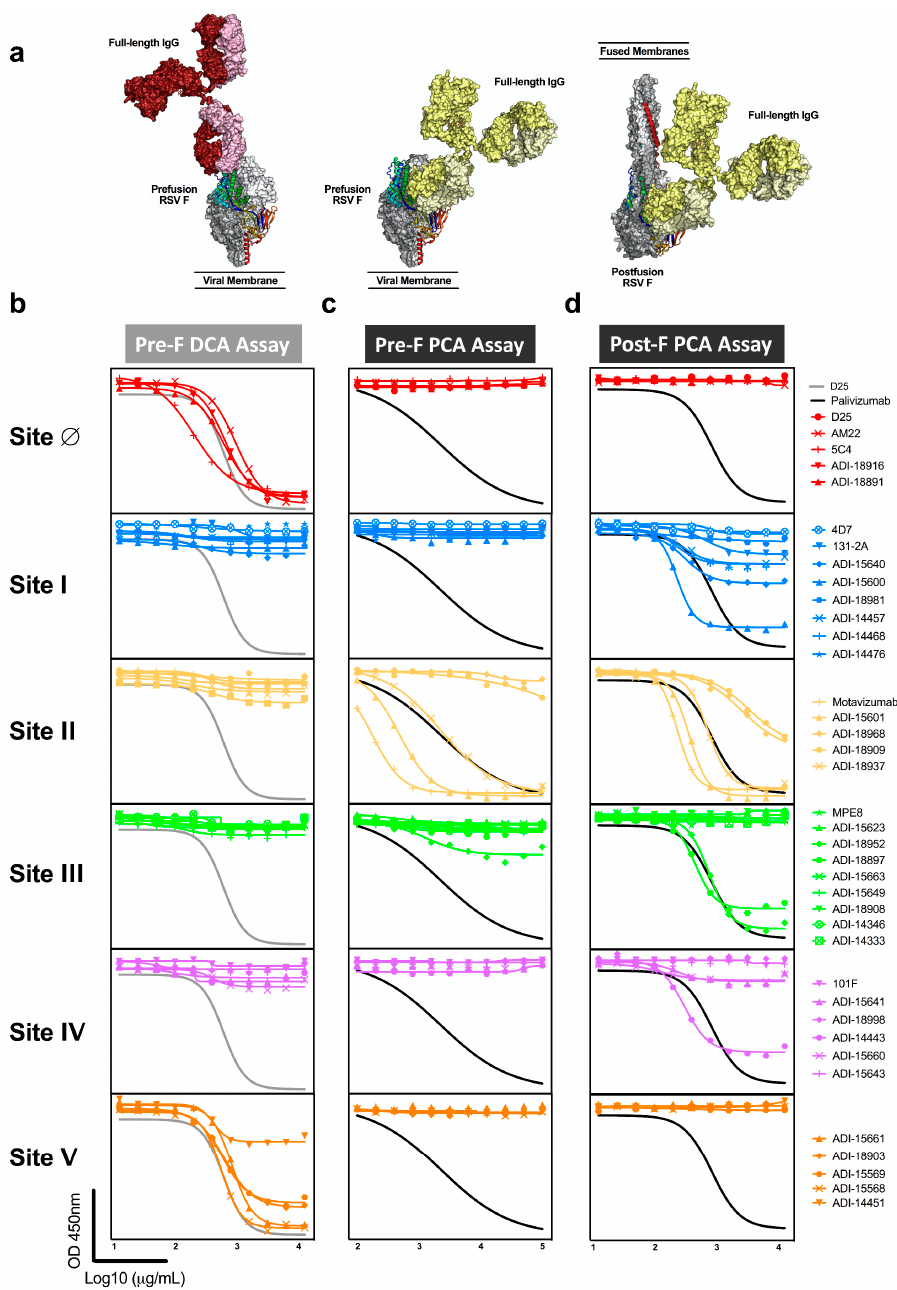
Figure 3. Antibodies targeting adjacent antigenic sites compete with D25 and palivizumab in mAb competition assays. ( a ) One antigen-binding fragment (Fab) of the full-length human IgG1 structure (Protein Data Bank ID: 1IGT) was aligned with the Fab from the complex of pre-F with D25 (red, site Ø), pre-F with motavizumab (yellow, site II), or post-F with motavizumab (yellow, site II) to highlight the relative size of the full-length immunoglobulins (Ig) to pre-F and post-F. ( b – d ) A panel of site-specific monoclonal antibodies (detailed in Table 1) was tested for competition in the pre-F DCA ( b ), pre-F PCA ( c ), and post-F PCA ( d ) assay. All of the antibodies in the panel specific to sites Ø and V competed with D25 in the DCA assay ( b ). One site III and multiple site II antibodies competed with palivizumab for binding to pre-F ( c ). Multiple antibodies binding antigenic sites I, II, III, and IV competed with palivizumab for binding to post-F ( d ). Antibodies that exceeded 25% competition of the biotinylated antibody are reported as competing in Table